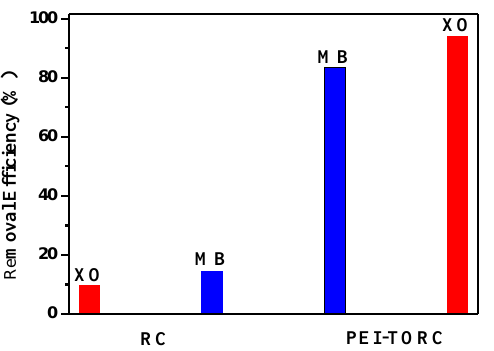
Figure 4. The removal efficiencies of RC and PEI-TORC (initial dye concentration: 30 mg·L −1 , 60 mL MB or XO solution, 70 mg adsorbent, 100 min, pH = 6.8).